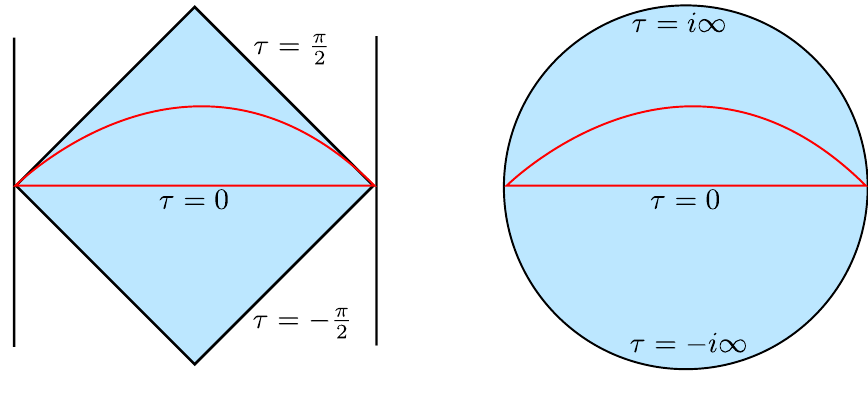
Figure 3 . We show the WdW patch in Lorentzian (left) and Euclidean AdS